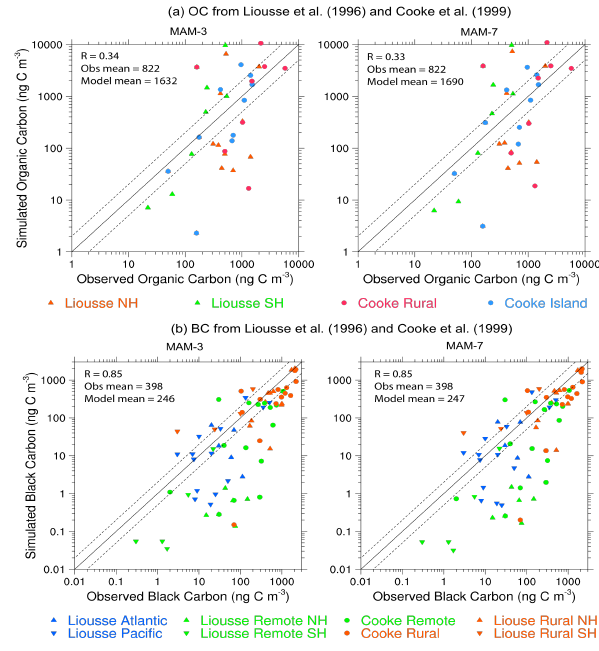
Fig. 13. Observed and simulated organic carbon (OC) (top) and Figure 13. Observed and simulated organic carbon (OC) (top) and black carbon (BC) black carbon (BC) (bottom) concentrations (ngCm − 3 ) at various (bottom) concentrations (ng C m -3 ) at various locations and time periods. Observations are from the compilations of Liousse et al. (1996) and Cooke et al. (1999). Simulated locations and time periods. Observations are from the compilations values for MAM3 (left) and MAM7 (right) are from model lowest layer, and OC is the of Liousse et al. (1996) and Cooke et al. (1999). Simulated values modeled (POM + SOA)/1.4. for MAM3 (left) and MAM7 (right) are from model lowest layer, and OC is the modeled (POM + SOA)/1.4.